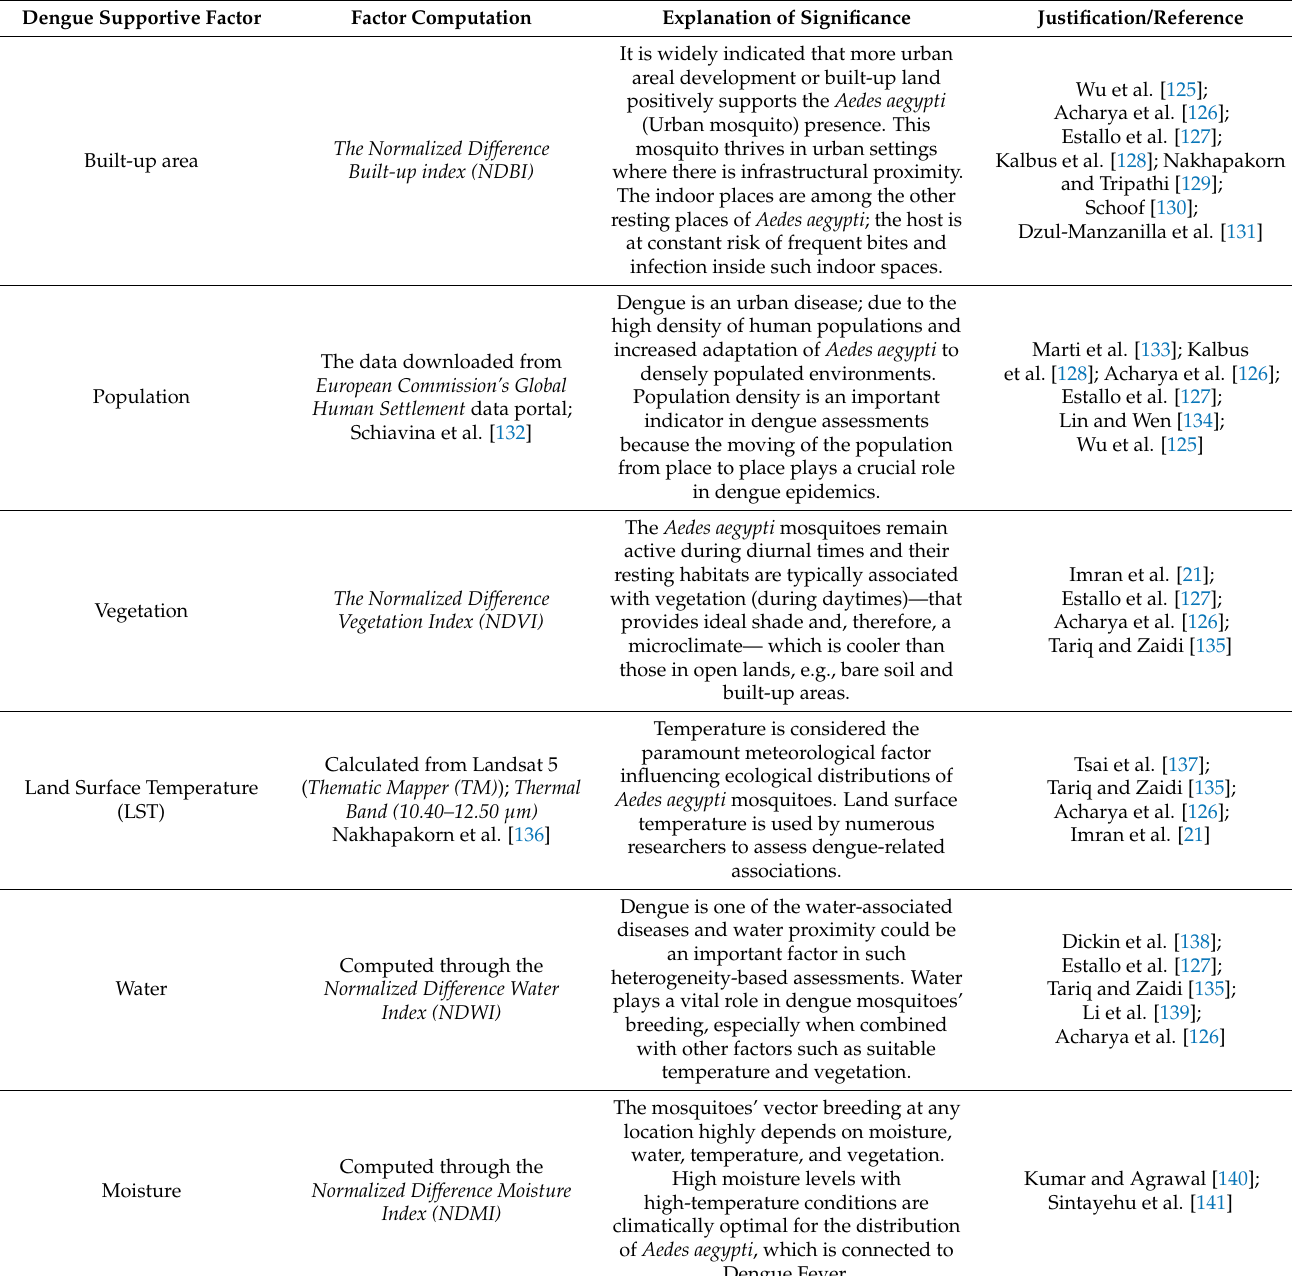
Table 1. Justification of vital indicators used in the GWR